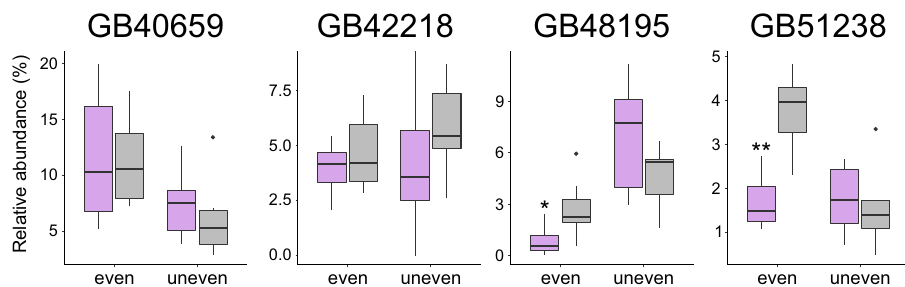
Fig. 8 Relative abundance of alkenes with double bonds at even and at uneven positions in fatty acid desaturase RNAi-treated bees and control bees. Box plots of the relative abundances of alkenes in bees treated with dsRNA of fatty acid desaturases ( GB40659 , GB42218 , GB48195 , GB51238 ; purple) or dsRNA of GFP (control; grey). Asterisks indicate statistically signi fi cant abundance differences between the two groups (RNAi treated vs. control) after Holm-Bonferroni correction for multiple ( N = 10) testing (Welch ’ s t-test/Wilcoxon signed-rank test: p ≤ 0.05 [*], p ≤ 0.01